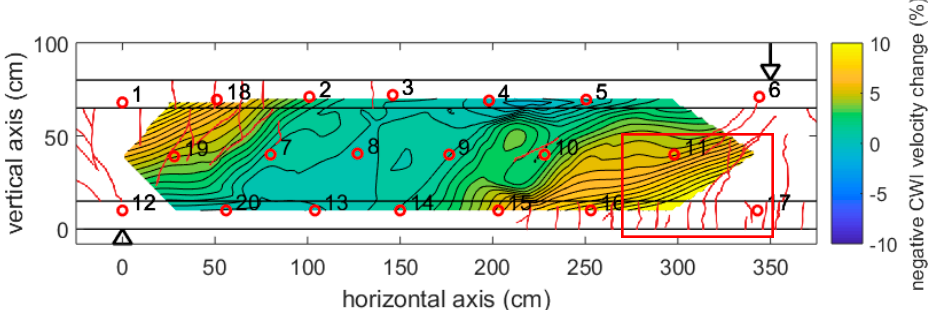
Figure 13. Girder DLT 1.3: As Figure 11, but 1250 kN load. Red lines: cracks visible at surface. Red rectangle: surface covered by paint for digital image correlation (no cracks visible). Note: different color scale for velocity change.